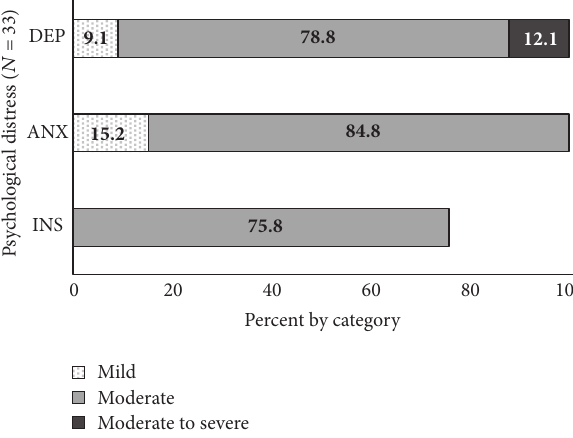
Table 1: Demographic characteristics of participants ( 𝑁 = 33 ).